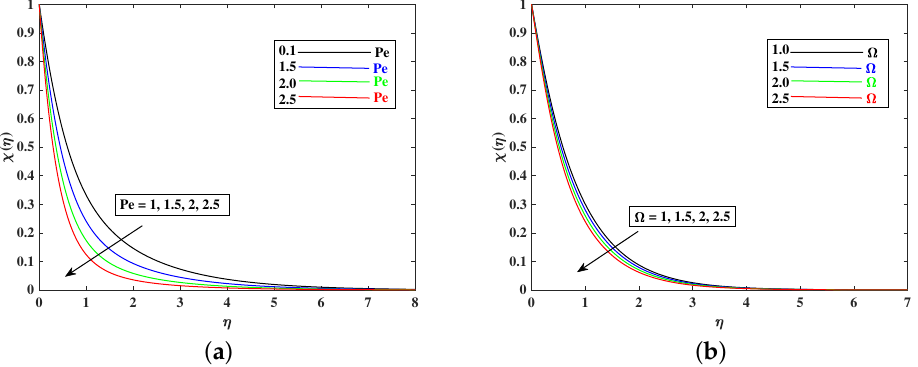
Figure 14. Variation of Pe ( a ) and Ω ( b ) to influence the bioconvection field. ( a ) Variation of Pe to influence the bioconvection profile. ( b ) Variation of Ω to influence the bioconvection